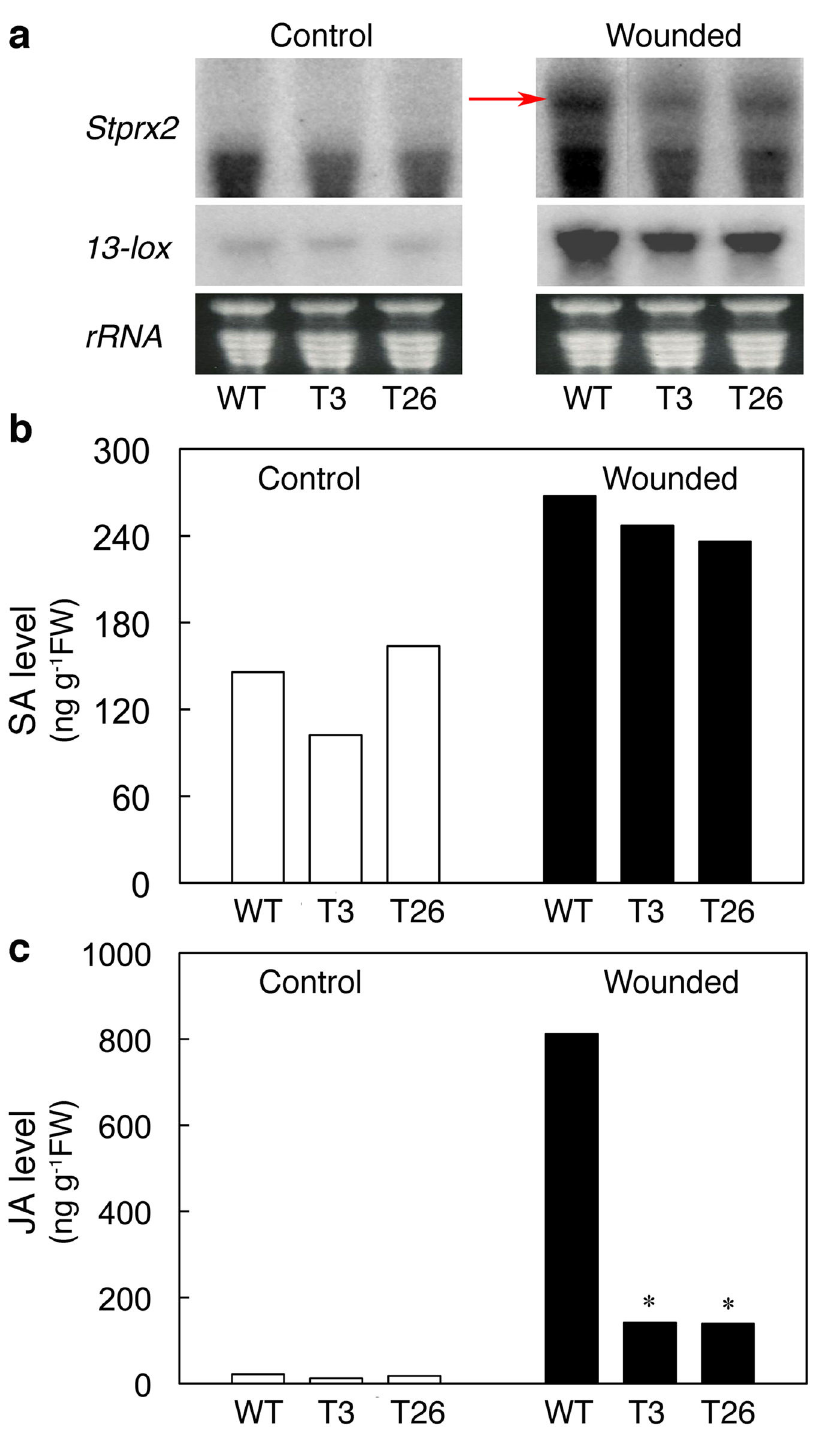
Figure 5. Stprx2 expression and levels of salicylic acid (SA) and jasmonic acid (JA) in control and wounded leaves from msrA3 -transgenic (T3 and T26) and wild-type (WT) plants. (a) Expression of Stprx2 (indicated by arrow) and 13-lox transcripts in WT and transgenic leaves 1 h after wounding. RNA loading was the same as described in legend to Figure 2c. (b) Levels of SA and (c) JA in WT and transgenic leaves 1 h after wounding. The values are average of two independent experiments. Wounding was carried out the same as described in the legends to Figure 4. * p < 0.05 refers to comparison between WT and transgenic (T3 or T26) leaves. doi: 10.1371/journal.pone.0077505.g005 PLOS ONE |